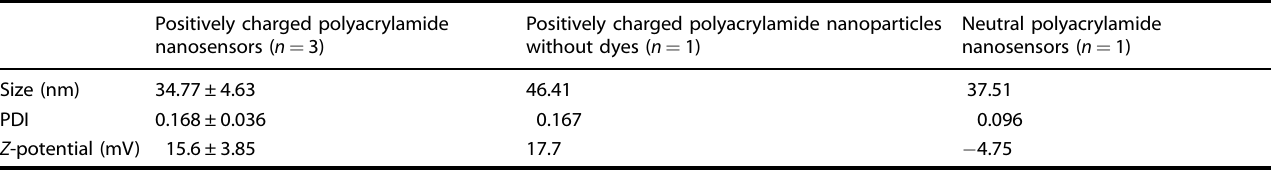
Table 1. Characteristics of the nanosensors synthesised in this